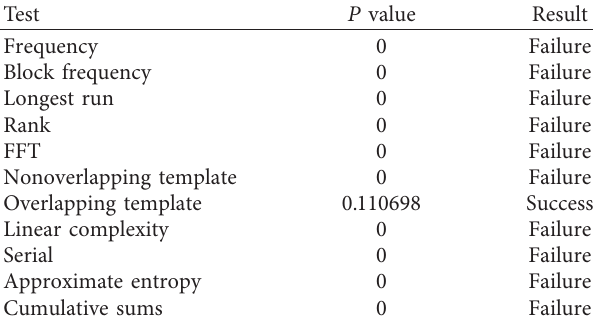
Table 2: Pseudorandom properties of torus-chaotic system.